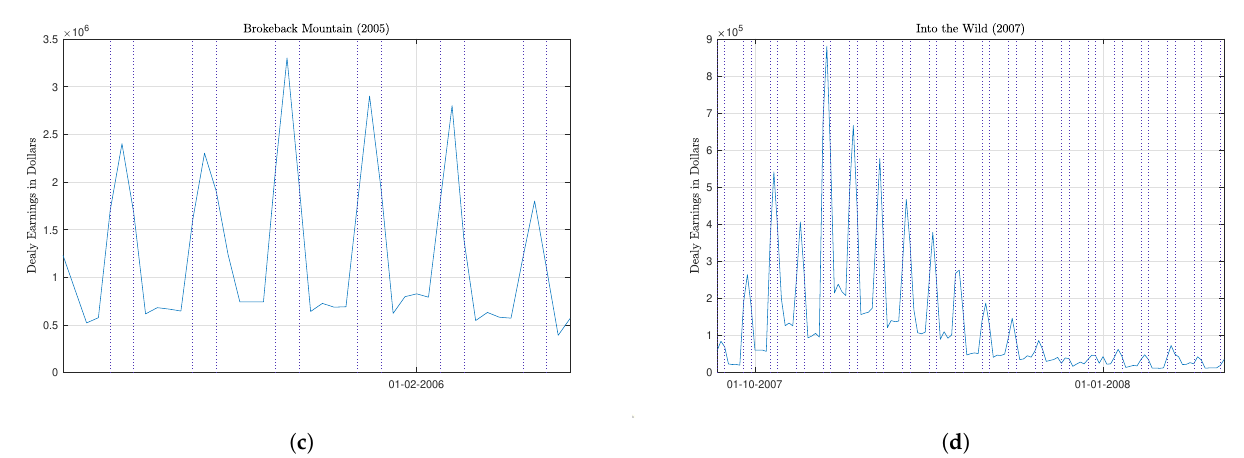
Figure 6. Series of daily earnings for 4 movies. Dotted vertical lines represent weekends. The two movies in top panels ( a , b ) have the usual trajectory for a movie: daily earnings decline with time with peaks during the weekend. In bottom panels ( c , d ) we show two cases of movies that start with moderate earnings that increase in the subsequent weeks and then decline.